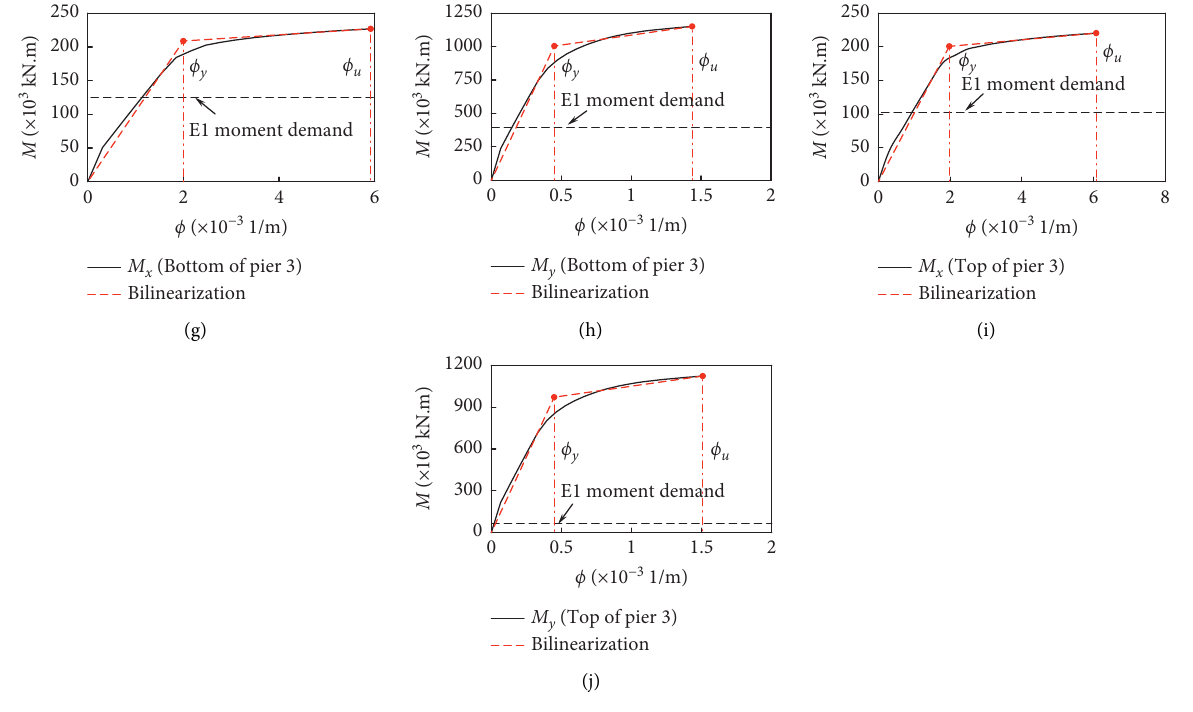
Figure 8: Moment-curvature diagram for critical pier